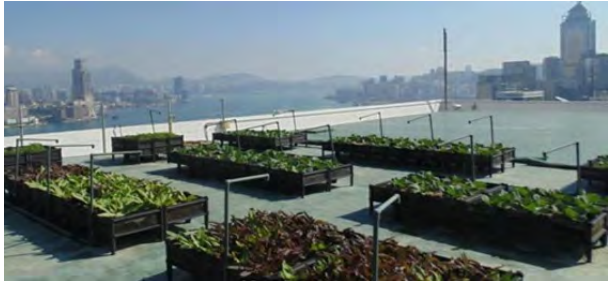
Figure 4. Farm built on the surface of the tower, “Bank of America” Hong